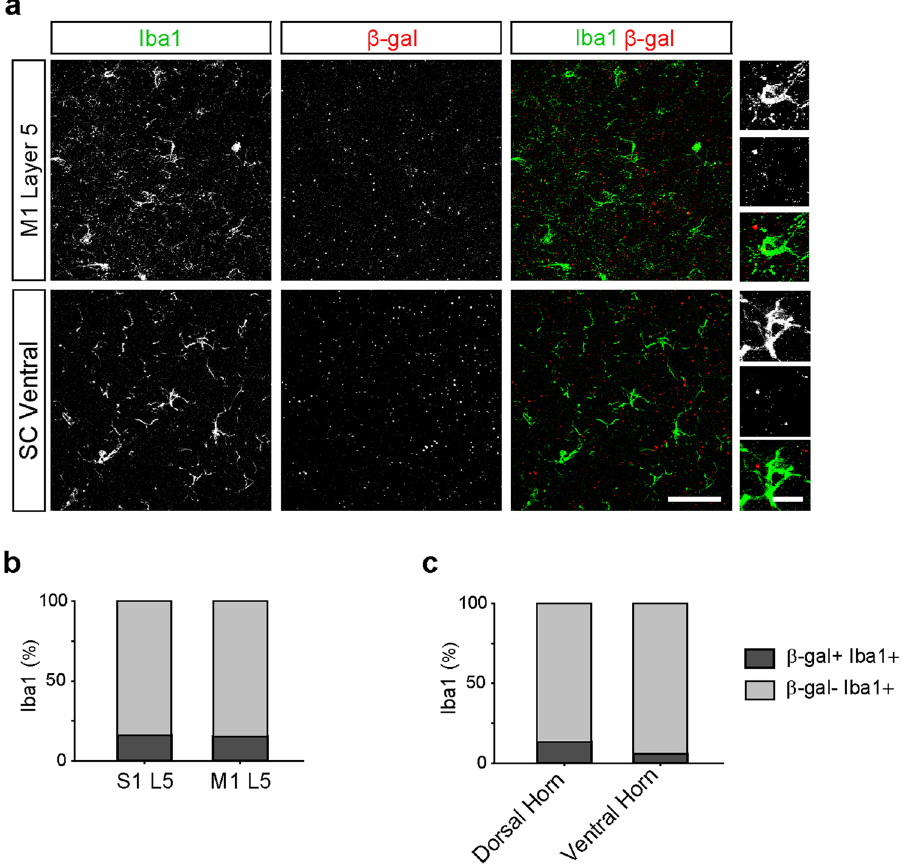
Figure 6. C9orf72 promoter activity is detected in few microglia. ( a ) Representative images of layer 5 (L5) of primary motor cortex (M1, top ) and the ventral horn of the spinal cord (SC, bottom ) of C9orf72 LacZ/ + mice immunostained for Iba1-positive microglia (green) and β -gal (red). High magnification images show microglia which do not contain β -gal puncta in the motor cortex ( top right ) and the spinal cord ( bottom right ). Scale bars: 50 μ m and 10 μ m. The percentage of microglia containing β -gal puncta in L5 of the primary motor and primary somatosensory cortex ( b ) L5 of somatosensory cortex: 16 of 127 cell, 16.0%; L5 of motor cortex: 22 of 160 cells, 15.2%; n = 7 mice for each group, p = 0.7749, Chi-Square test) and the spinal cord ( c ; dorsal spinal cord: 14 of 106 cells, 13.2%; ventral spinal cord: 2 of 34 cells, 5.9%, n = 3 mice for each group, p = 0.2427, Chi-Square